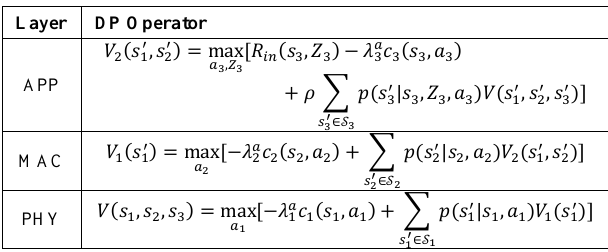
Table 1. DP operator of each